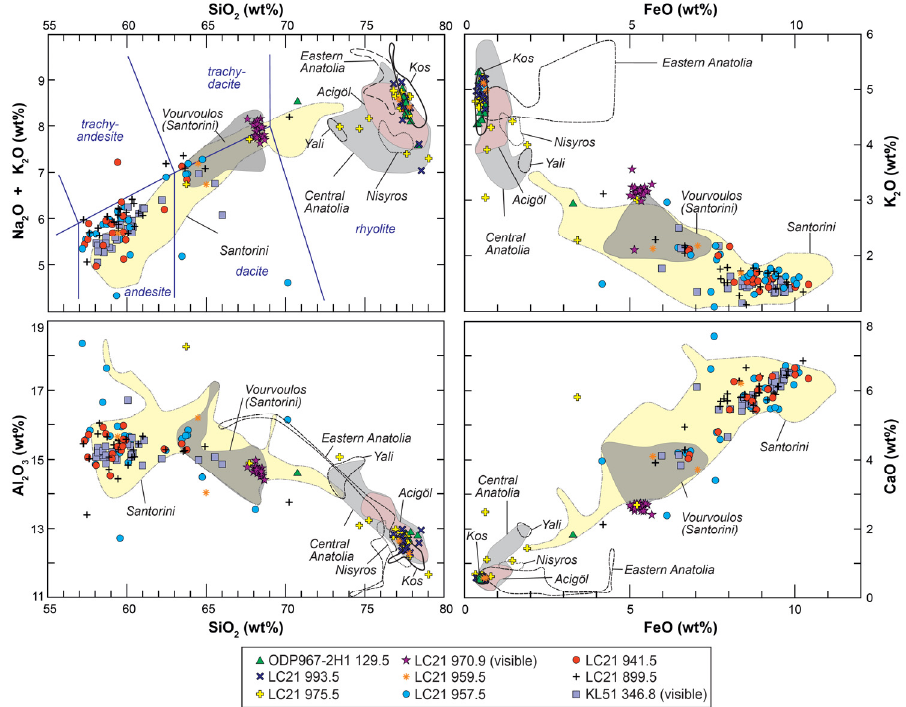
Figure 5. Top left : Total Alkali vs. Silica (TAS) diagram (after [77]) showing samples analysed in this study. Other panels show selected major element biplots of glass geochemistry from electron probe microanalysis (EPMA) of the tephra samples in this study. Reproducibility is <10% relative standard deviation for analyses with concentrations >0.8 wt% with the exception of Na 2 O (14%–15%). Full analytical results and standard analyses are provided in the supplementary data. Data for the LC21 970.9 (visible) tephra and LC21 957.5 are from [17]. Also shown are analyses of proximal tephras for comparison from: Santorini [48], Eastern Anatolia [78]; Central Anatolia including Acigöl [48,79]; Kos [17]; Nisyros [58]; Yali [13,14]. The geochemical field defined by proximal analyses of the Vourvoulos eruption of Santorini is shown separately from the rest of the Santorini field; see discussion in text.